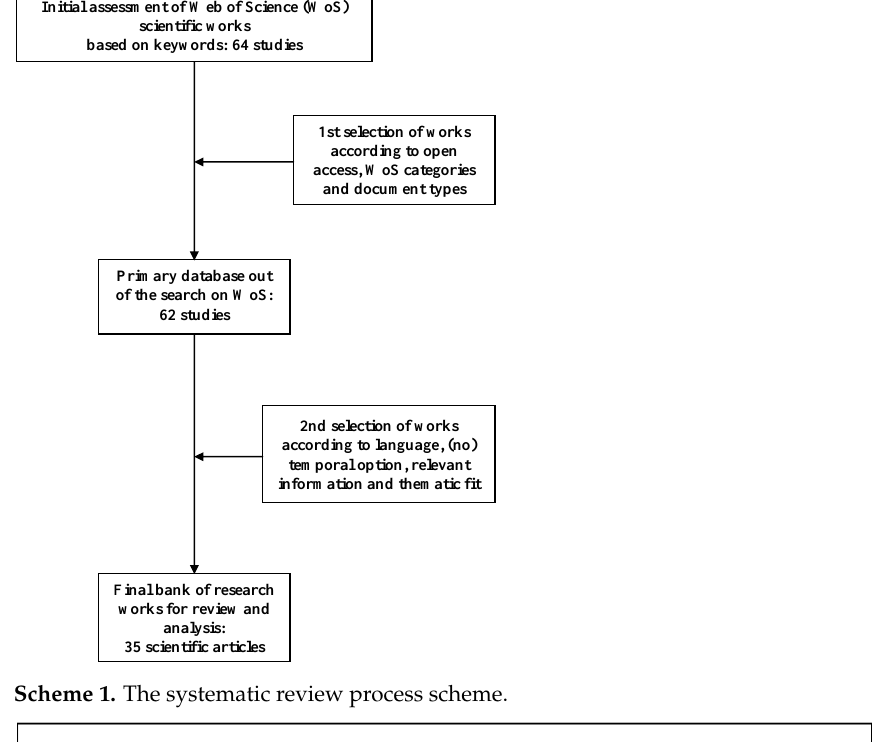
Table 1 emphasizes our review landmarks: Table 1. The WoS platform review process results on COVID-19 impact on water quality.